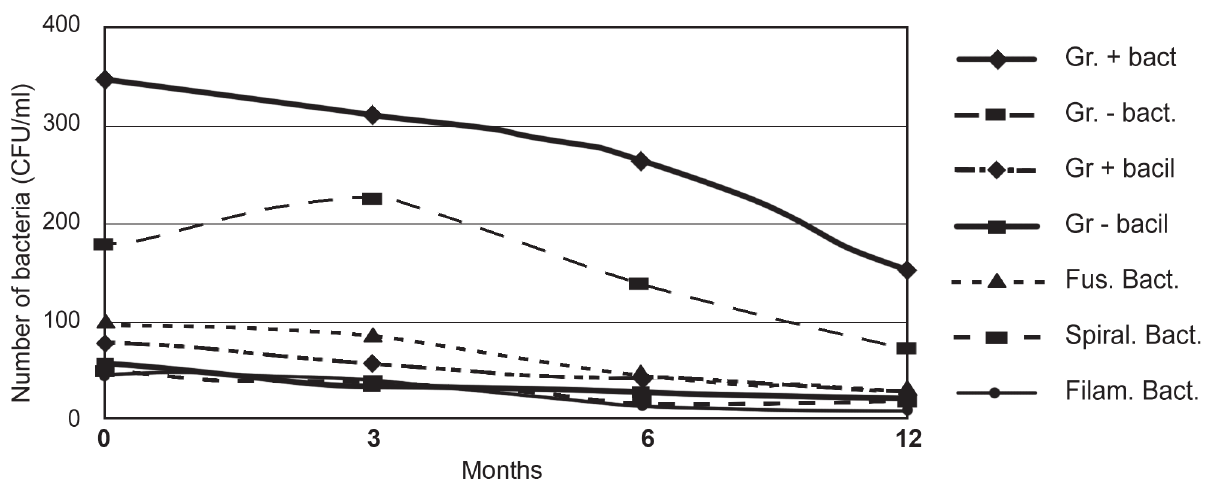
Figure 3- Average number of bacteria in dental plaque inside visible field in the defined observation